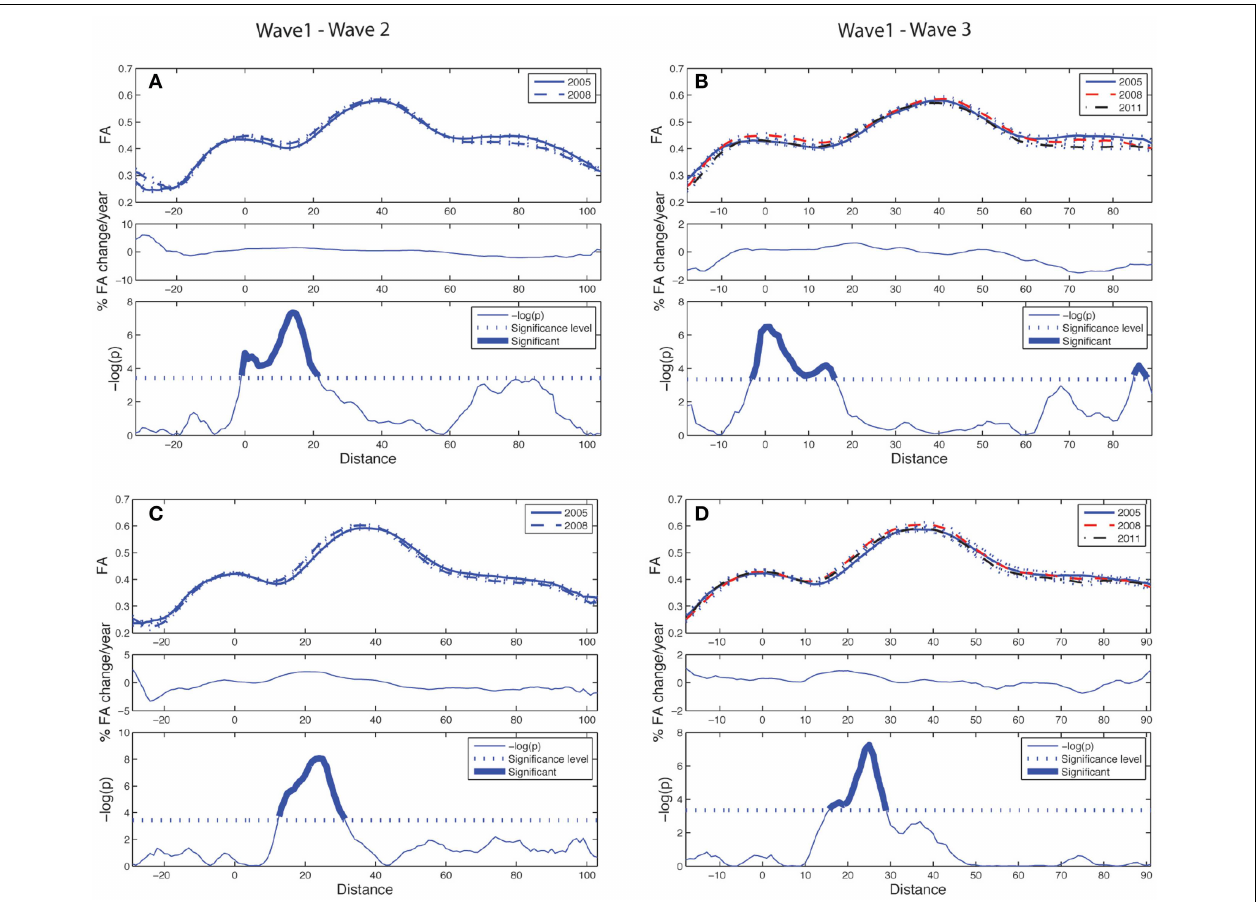
FIGURE 5 | Tract parameterization of the CST for the two-wave (left column) and the three-wave (right column) analyses. The individual trajectories of the CST, initialized from only one ROI, is normalized into 100 equidistant segments where 0 on the normalized distance axis is located along the CST in the middle part of the precentral WM region, and segment 100 is at a cut at the lower level of the brainstem (cf. image inserts in lower parts of left and right column in Figure 3 ). (A) Upper panel: Mean FA ± SE (dotted lines) profile of left hemispheric CST at Wave-1 (continuous line) and Wave-2 (broken line). Middle panel: Segment-wise percentage change in mean FA per year in the